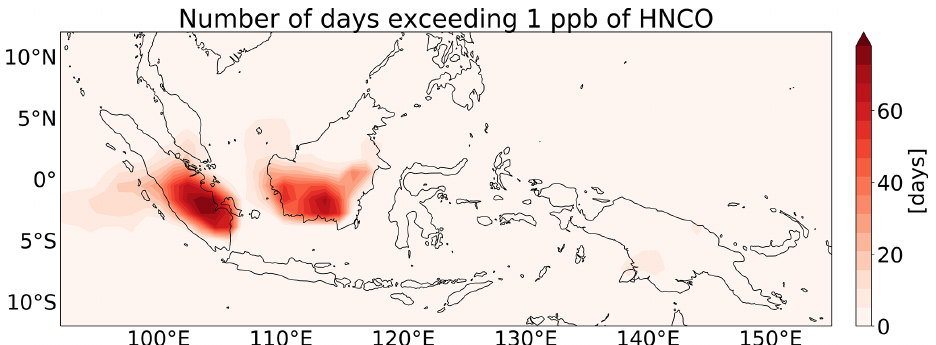
Figure 8. Number of days in which ambient concentrations of 1ppb of HNCO are exceeded during the Indonesian peatland fires in 2015 between August and October.